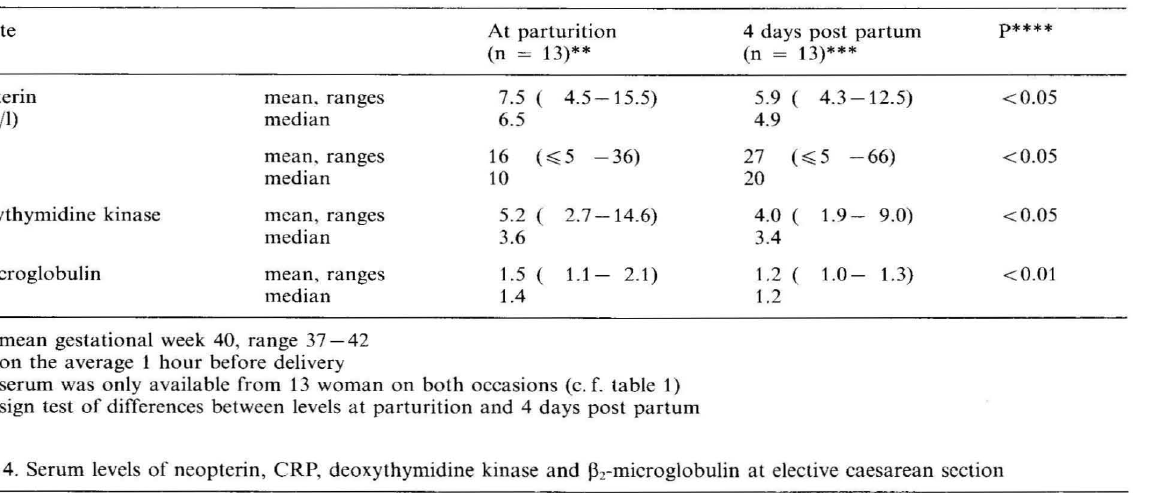
Table 4. Serum levels of neopterin, CRP, deoxythymidine kinase and ~2-roicroglobulin at elective caesarean section Analyte*